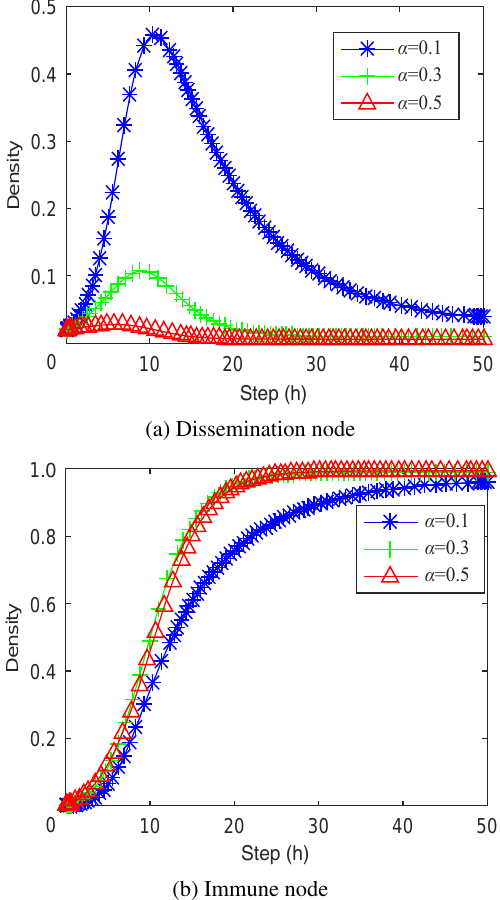
Fig. 7 Densities of dissemination and immune nodes with different values of ˛˛˛